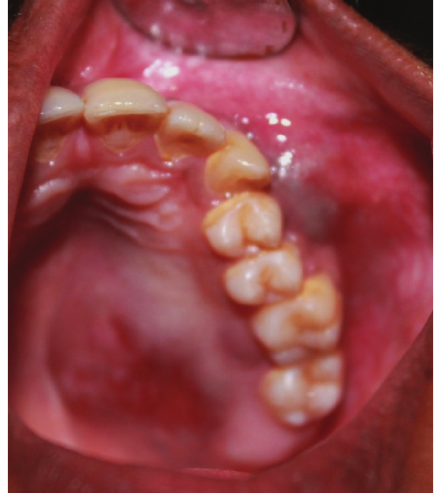
Figure 2: Intraoral swelling over left maxilla.